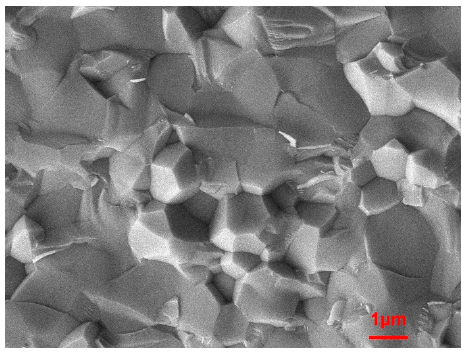
Figure 1. SEM micrograph of the Nd:LuAG ceramics.